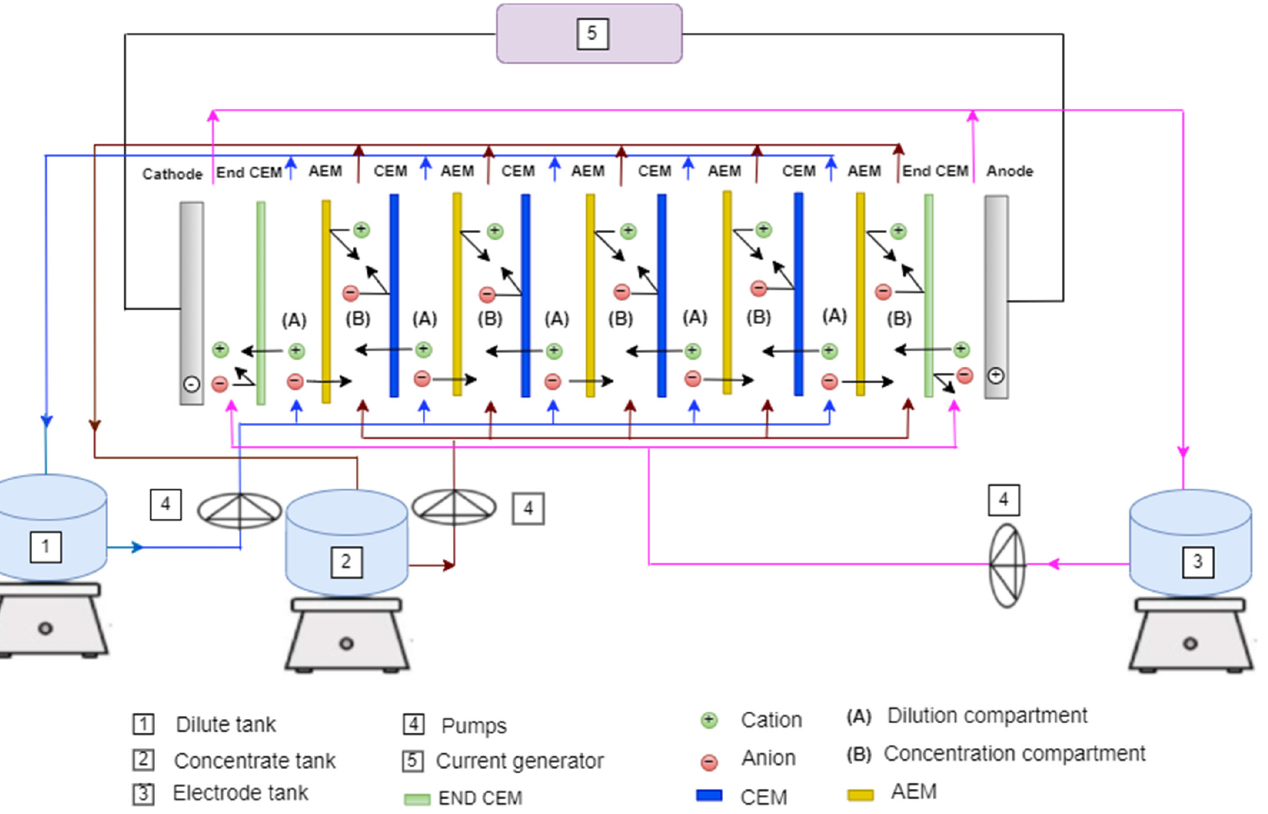
Figure 2. Schematic of the ED system: batch recirculation mode.